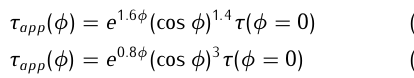
Comparison of the Cunha [29] experimental results for smooth and hooked steel fiber with two different fiber embedment lengths (10 and 20 mm) reveals that the best agreement can be proposed by utilizing Equation (7); and for embedment length 30 mm by utilizing Equation (8) as presented